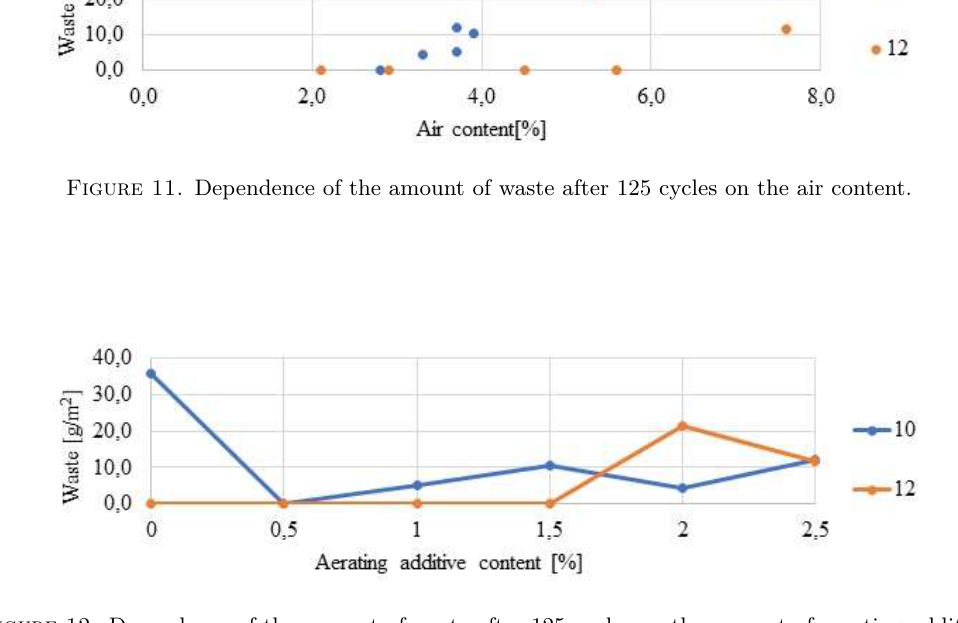
Figure 12. Dependence of the amount of waste after 125 cycles on the amount of aerating